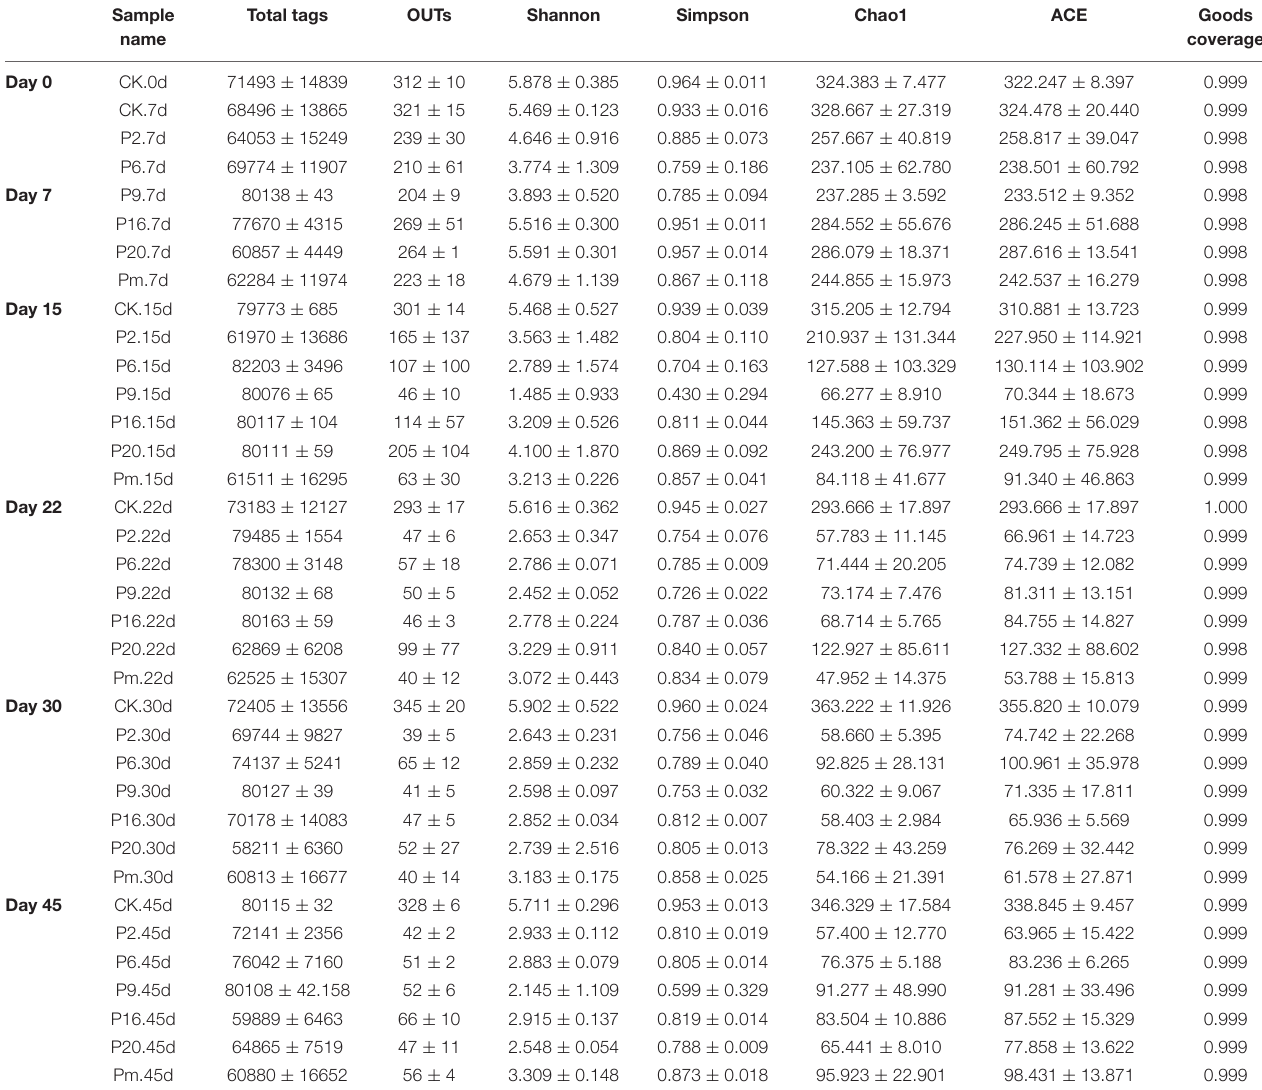
TABLE 3 | Alpha diversity estimation of the 16S rRNA gene libraries by sequencing on an Ion S5TM XL platform in